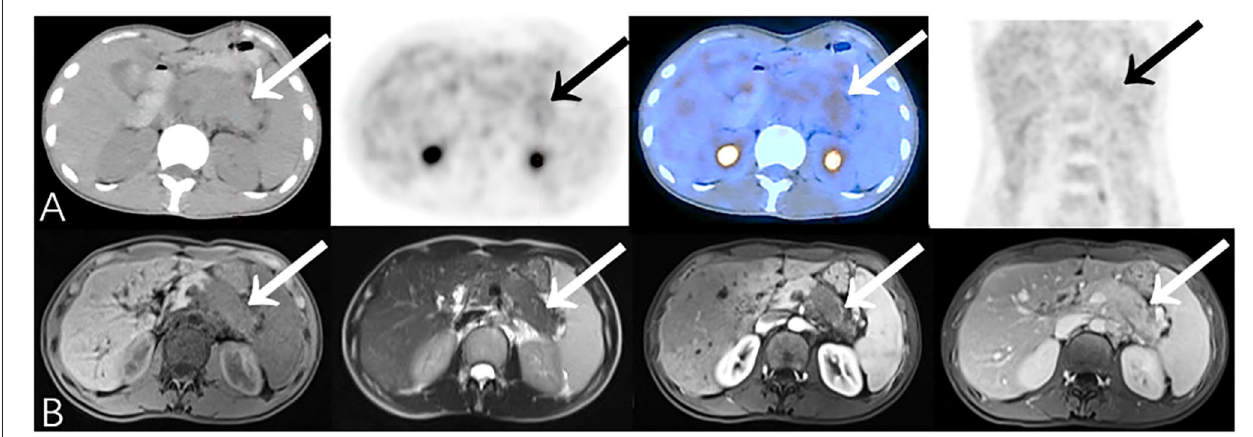
FIGURE 5 | Representative patient on PET/CT (False-Negative) compared to CEMR (True-Positive): A 37-year-old female experienced epigastric pain for 4 months. Serum CA19-9 was elevated (259.4 U/mL). (A) The body and tail of pancreas were slightly swollen with slightly increased 18 F-FDG uptake (SUVmax 3.1). There was insufficient evidence of malignancy on PET/CT especially when no other significant abnormality was identified on the rest of the body scan. (B) CEMR showed a low-signal area on T1WI with narrowing of the pancreatic duct in the body and tail of pancreas which has no significant density change on PET/CT due to relatively limited resolution. The lesion enclosed retroperitoneal vessels which was suggestive of pancreatic cancer. Biopsy result showed adenocarcinoma (differentiation unspecified). Patient died after 9.2 months.